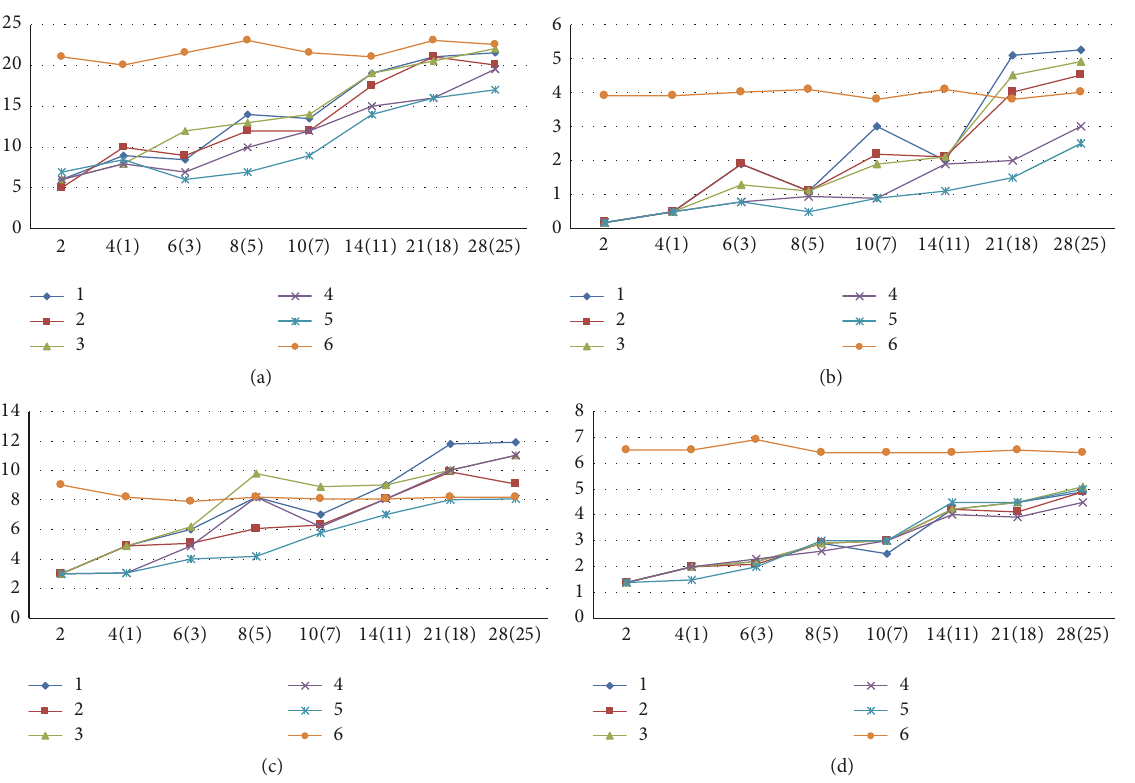
Figure 2: Myelogram of myeloid cells (a), the lymphoid cells (b), the granulocyte cells (c), and the erythrocyte cells (d) in the mice bone marrow,administrationof 11 aftertheinjectionofcyclophosphamidesolution(1),administrationof 6 aftertheinjectionofcyclophosphamide solution (2), administration of 9 after the injection of cyclophosphamide solution (3), administration of methyluracil after the injection of cyclophosphamide solution (4), control group (administration of placebo (saline) after the injection of cyclophosphamide solution) (5), and intact animals (6). Time in days, in parentheses, days after administration of the compounds (the abscissa axis); number of cells ⋅ 10 6 / 𝜇 L (the axes of